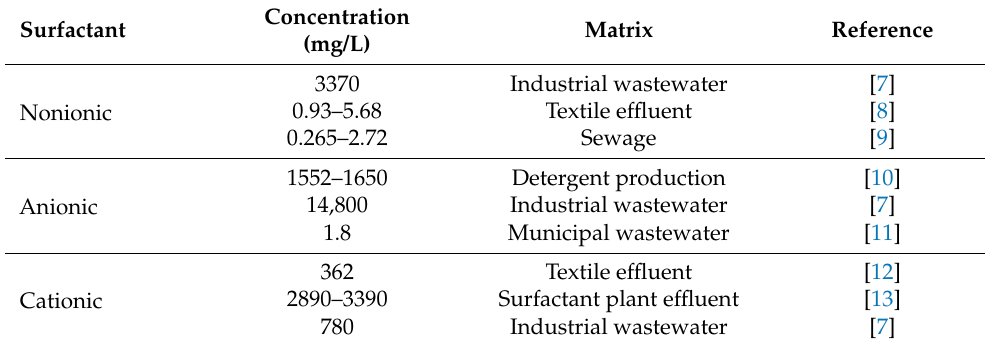
Table 1. Surfactant concentration in